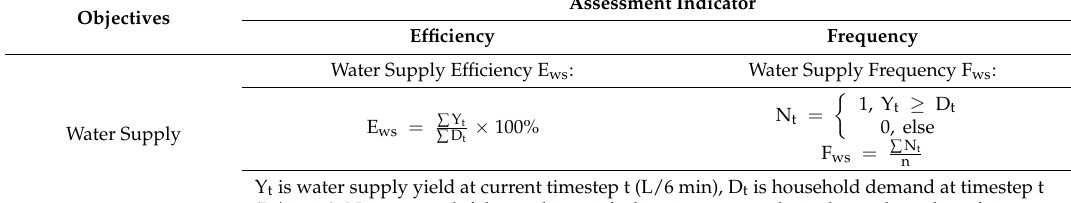
Table 3. Assessment metrics to characterize the system performance of triple objectives. Each of the triple objectives is evaluated by two parameters quantifying the amount and frequency, respectively.